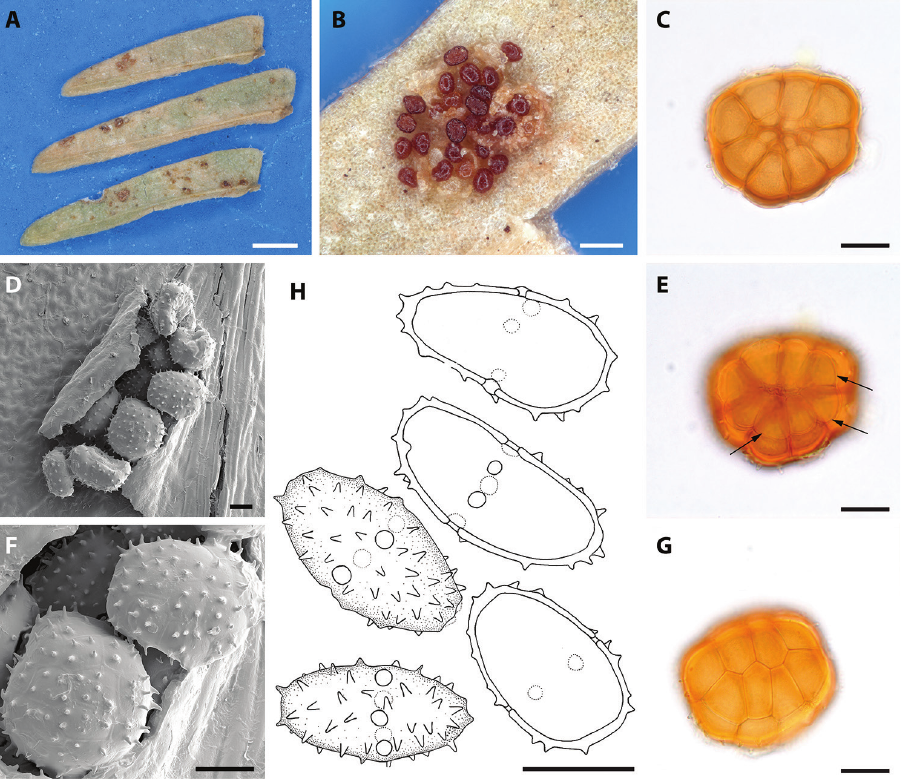
Type. Costa Rica, Guanacaste, Area de Conservación Guanacaste, Sendero Bosque húmedo (10°50.702'N, 85°36.450'W) on Senegalia tenuifolia (L.) Britton and Rose,